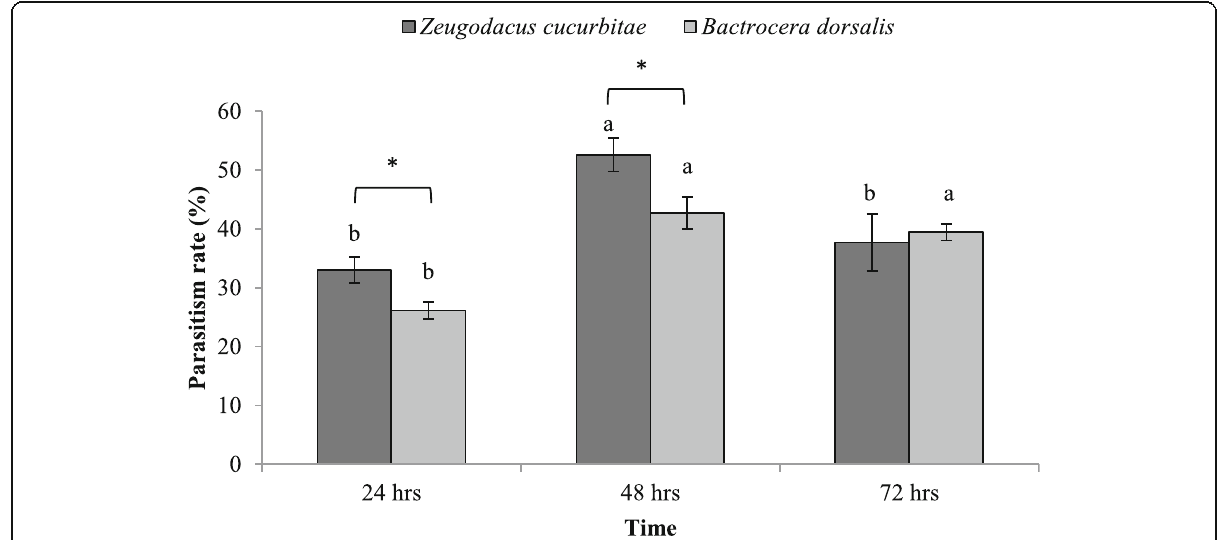
Fig. 1 Parasitism rate of Dirhinus giffardii after 24, 48, and 72 h exposures subjected for Z . cucurbitae and B . dorsalis pupae. Means followed by similar letter are non-significantly different at 0.05% level of significance (for black and white columns), while ns present non-significant difference at 0.05% level of significance. Asterisk (*) shows significant difference between the treatments and different pupae